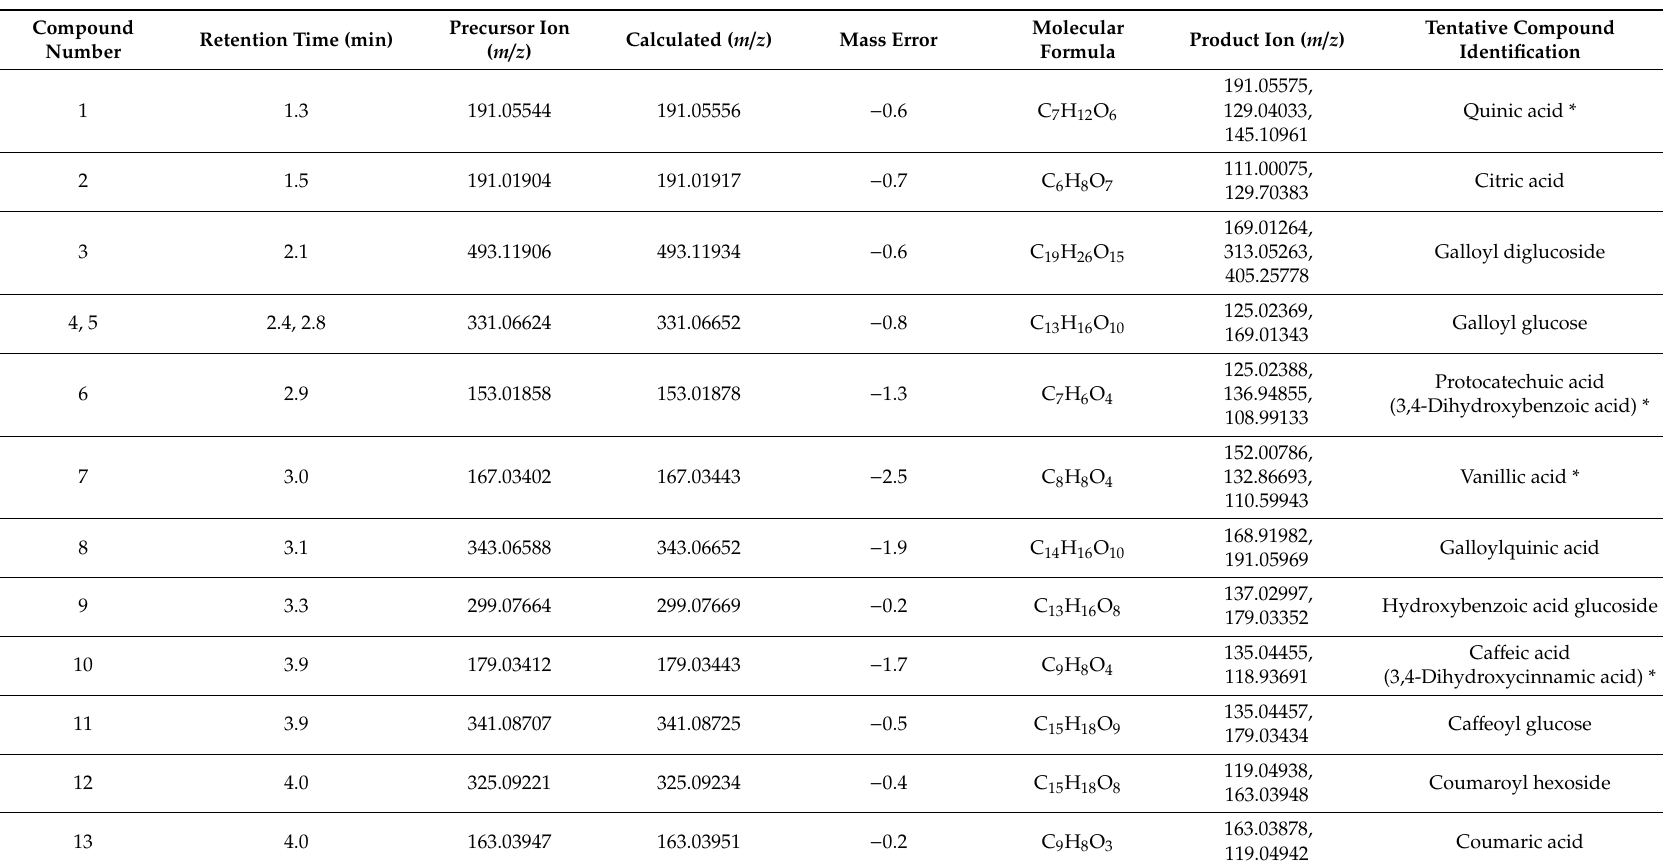
Table A1. (Poly)phenolic compounds tentatively identified in IQF (individually quick frozen) mango pulp using UHPLC-Q-TOF mass